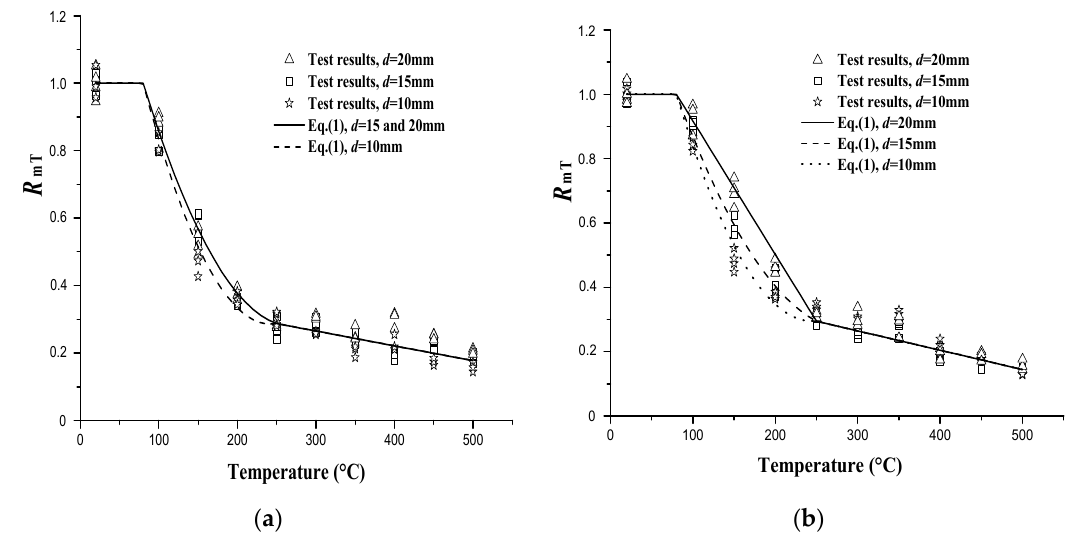
Figure 13. Comparison of R mT obtained from Equation (4) and experimental results: ( a ) single ‐ layer gypsum; and ( b ) double ‐ layer gypsum sheathing.